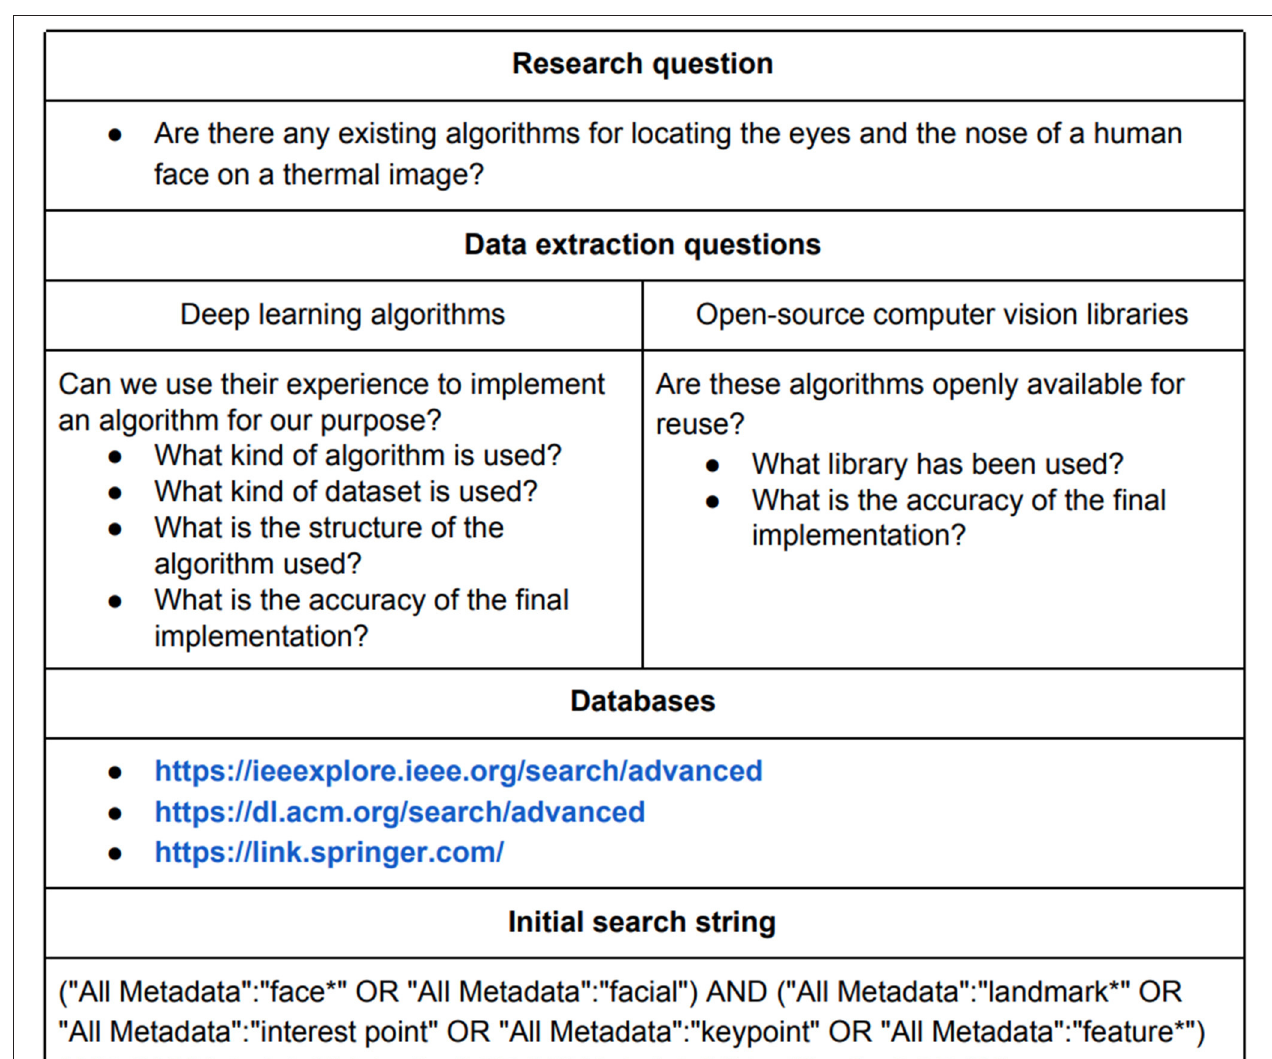
FIGURE 3 | Overview of setup for systematic literature